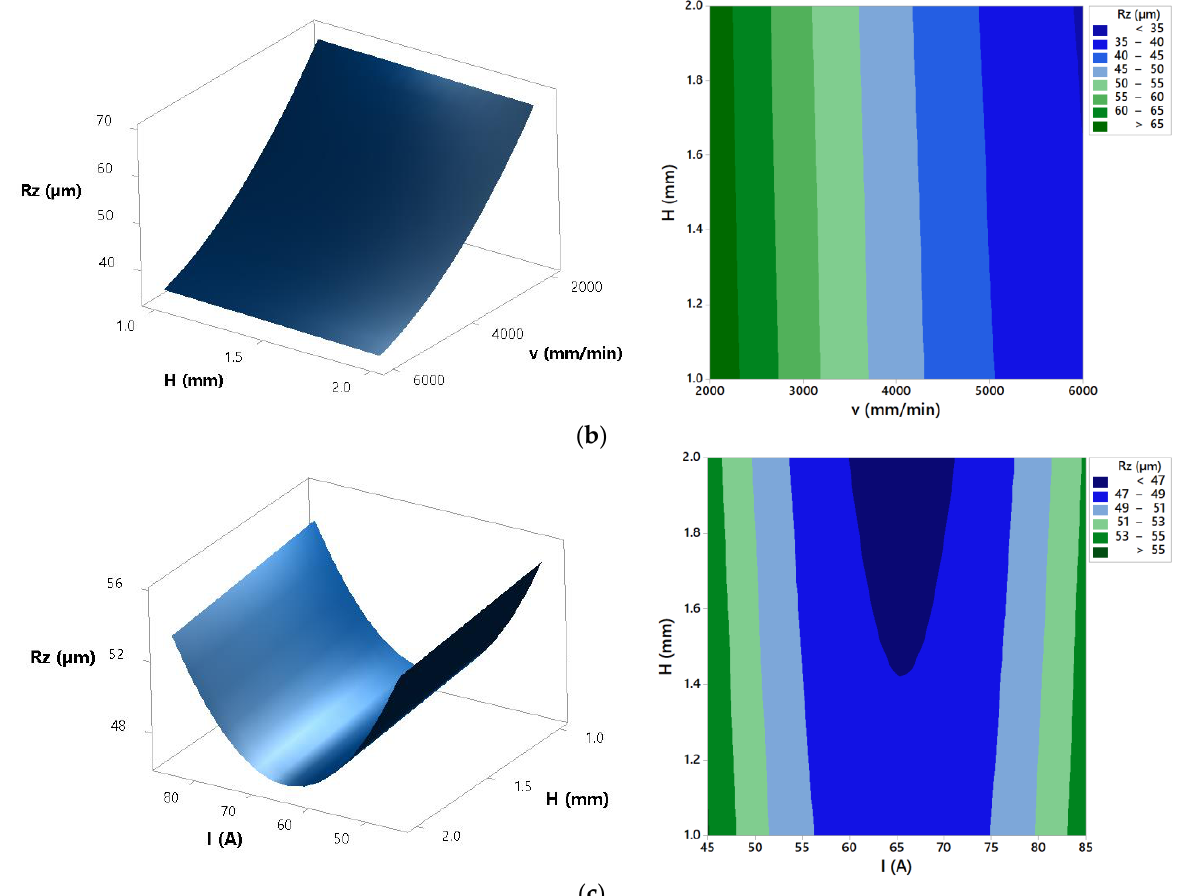
Figure 12. Effects of process parameters on surface roughness Rz : ( a ) H = 1.5 mm, ( b ) I = 65 A, and ( c ) v = 4000 mm/min.